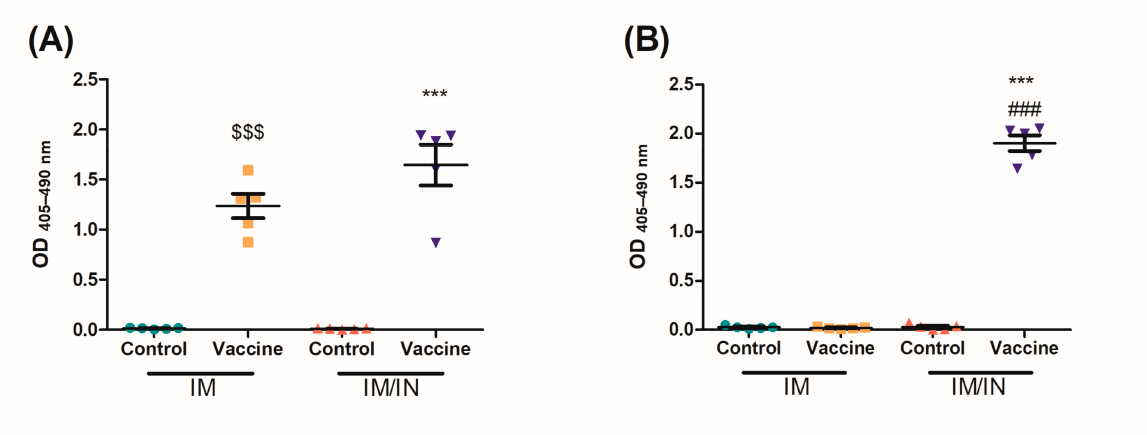
Figure 3. Levels of mucosal anti-nicotine antibodies in the lung after the final vaccination. Mice were vaccinated on days 0, 21 and 42 using PBS, or the vaccine either delivered heterologously (IM/IN) or IM. Five weeks after the final vaccination, bronchoalveolar lavages were assessed for anti-nicotine ( A ) IgG (1:50 dilution) and ( B ) IgA (neat) using an indirect ELISA. Data are represented as ± SEM and n = 5 for each group. Statistical significance was determined by an ANOVA with a Tukey HSD, $$$ p ≤ 0.001 and *** p ≤ 0.001 as compared to their respective controls, ### p ≤ 0.001 as compared to the IM vaccine